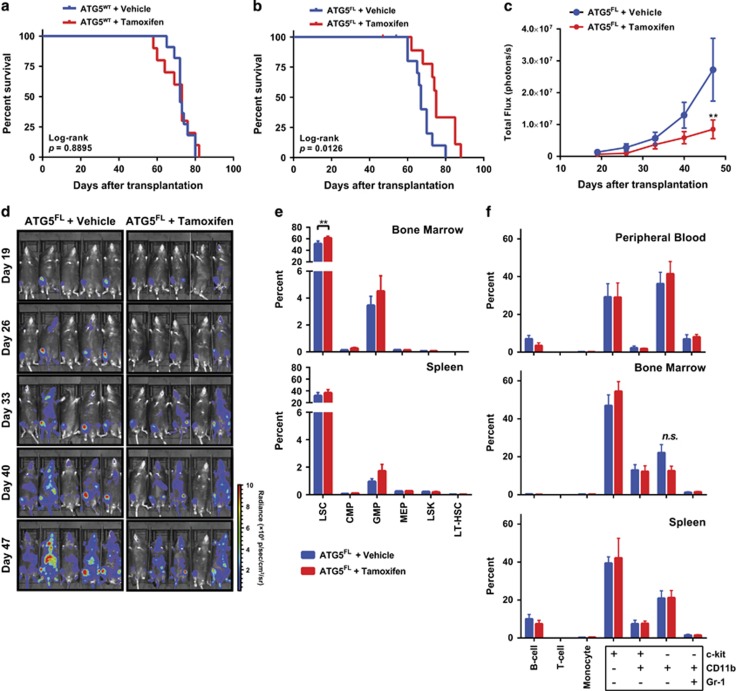
Vehicle and tamoxifen treatment in mice transplanted with ATG5WT and Atg5FL BM cells transduced with dMLL-AF9. (a and b) Kaplan–Meier survival curve of mice transplanted with Atg5WT (a) or Atg5FL (b) cells treated with vehicle or tamoxifen (n=11 for each group). The P-values for the log-rank test between vehicle and tamoxifen treatment are shown. (c) Quantification of in vivo bioluminescent imaging of Atg5FL mice from panel (b) is represented by total flux. Error bars represent S.E.M. of nine mice. Statistics were calculated by analysis of variance (ANOVA) with multiple comparisons. **P<0.01. (d) Representative animals for in vivo bioluminescence of mice from panel (b). Images were normalized to the scale bar at bottom right. (e) Flow cytometric analysis of Annexin V−7-AAD− cells in the indicated hematopoietic tissues of moribund mice from panel (b), showing the following cell populations: c-kit+Sca-1−CD16/32+CD34− LSCs, c-kit+Sca-1−CD16/32−CD34+ CMPs, c-kit+Sca-1−CD16/32+CD34+ GMPs,c-kit+Sca-1−CD16/32−CD34− MEPs, Lin−c-kit+Sca-1+ LSKs, and Lin−c-kit+Sca-1+CD48−CD150+ LT-HSCs. Error bars represent S.E.M. of eight mice. Statistics were calculated by ANOVA with multiple comparisons. **P<0.01. (f) Flow cytometric analysis of Annexin V−7-AAD− cells in the indicated hematopoietic tissues of moribund mice from panel (b) shows the populations of CD19+ B-cells, CD3+ T-cells, F4/80+ monocytes, and cells of the indicated phenotype. Statistics were calculated by ANOVA with multiple comparisons. NS, not statistically significant